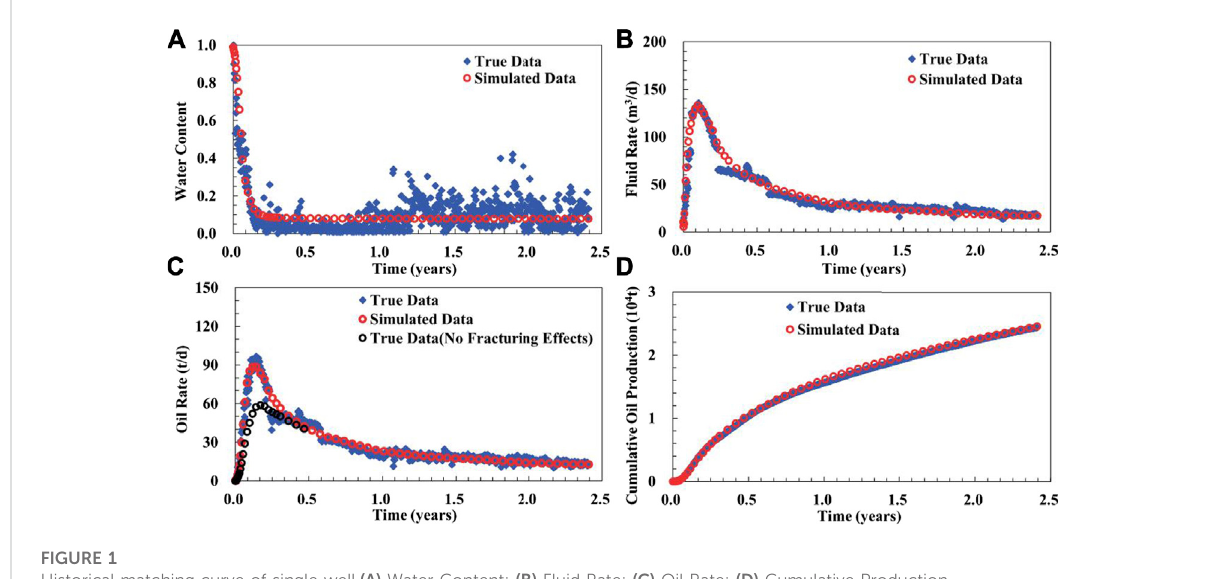
FIGURE 1 Historical matching curve of single well. (A) Water Content; (B) Fluid Rate; (C) Oil Rate; (D) Cumulative Production.